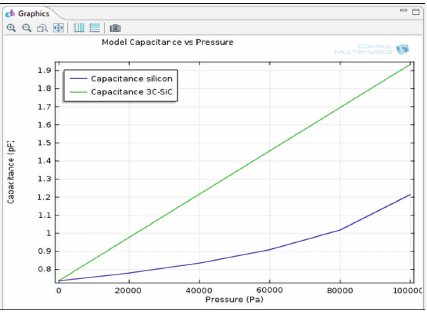
Figure 9: Plot of capacitance of the diaphragm versus pressure.